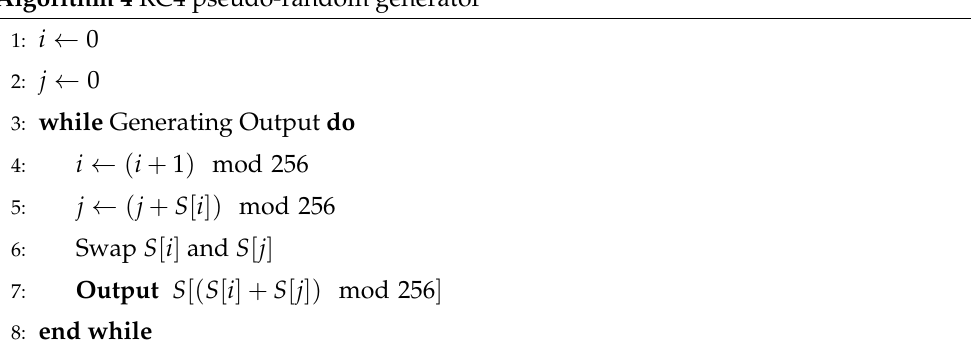
Algorithm 4 RC4 pseudo-random